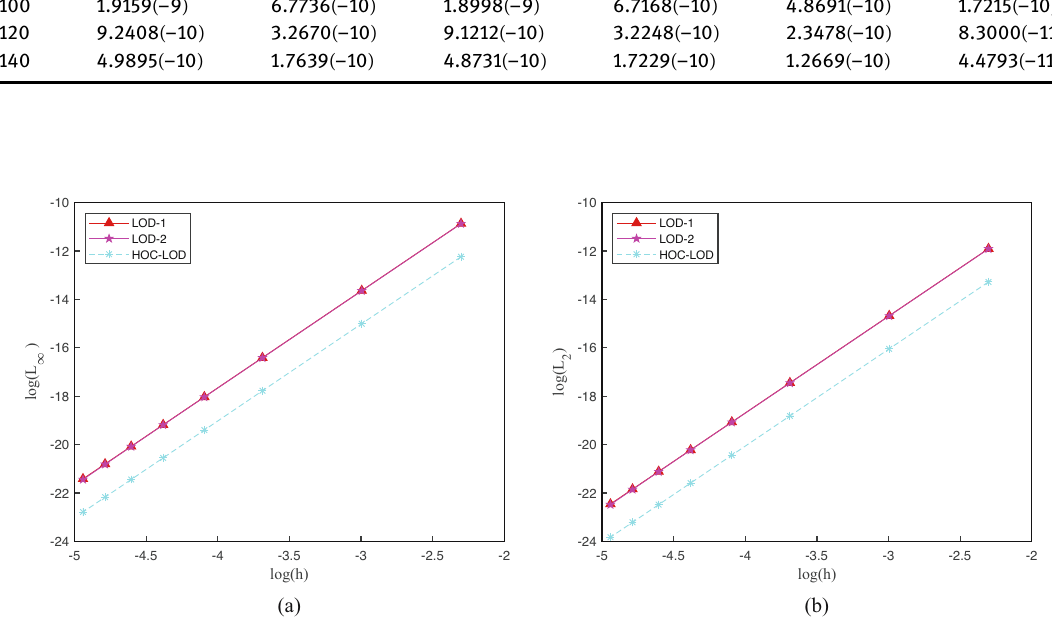
Figure 1: Log – log plots for the L ∞ ( a ) and L 2 ( b ) errors.